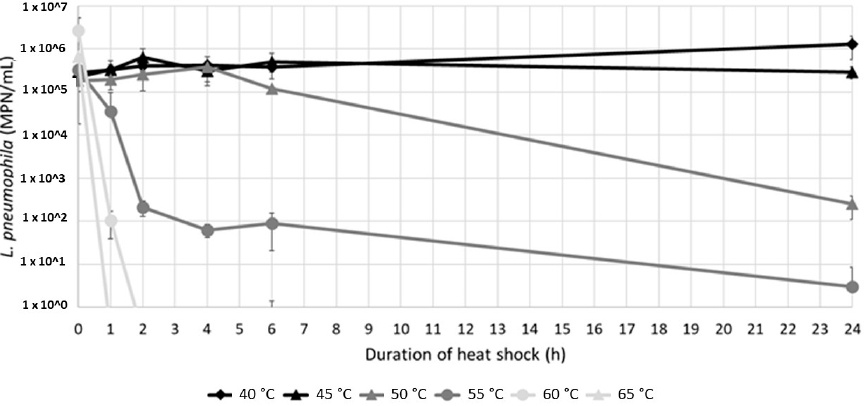
Figure 4. L. pneumophila concentrations (mean value of sludges A and B, n = 4) depending on the contact time and temperature. The detection limit of the enzymatic test is 1 MPN/mL.